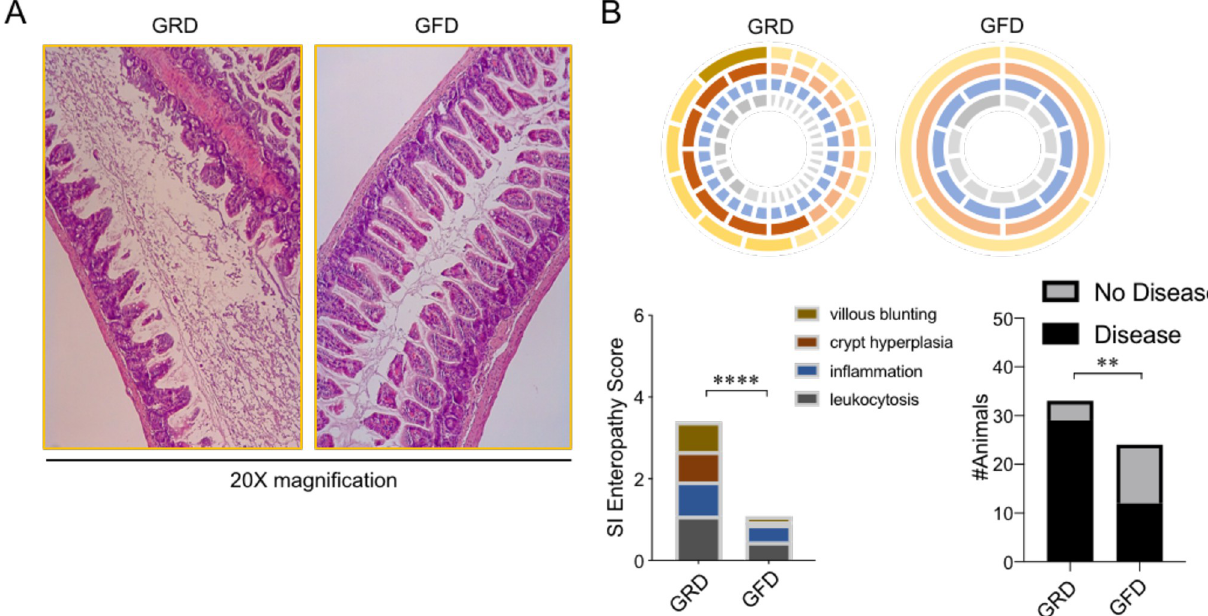
(B) Two-way repeated measure ANOVAs were used to compare the effects of genotype on the severity of SI enteropathy, and a two-sided Fisher’s exact test was used to compare disease